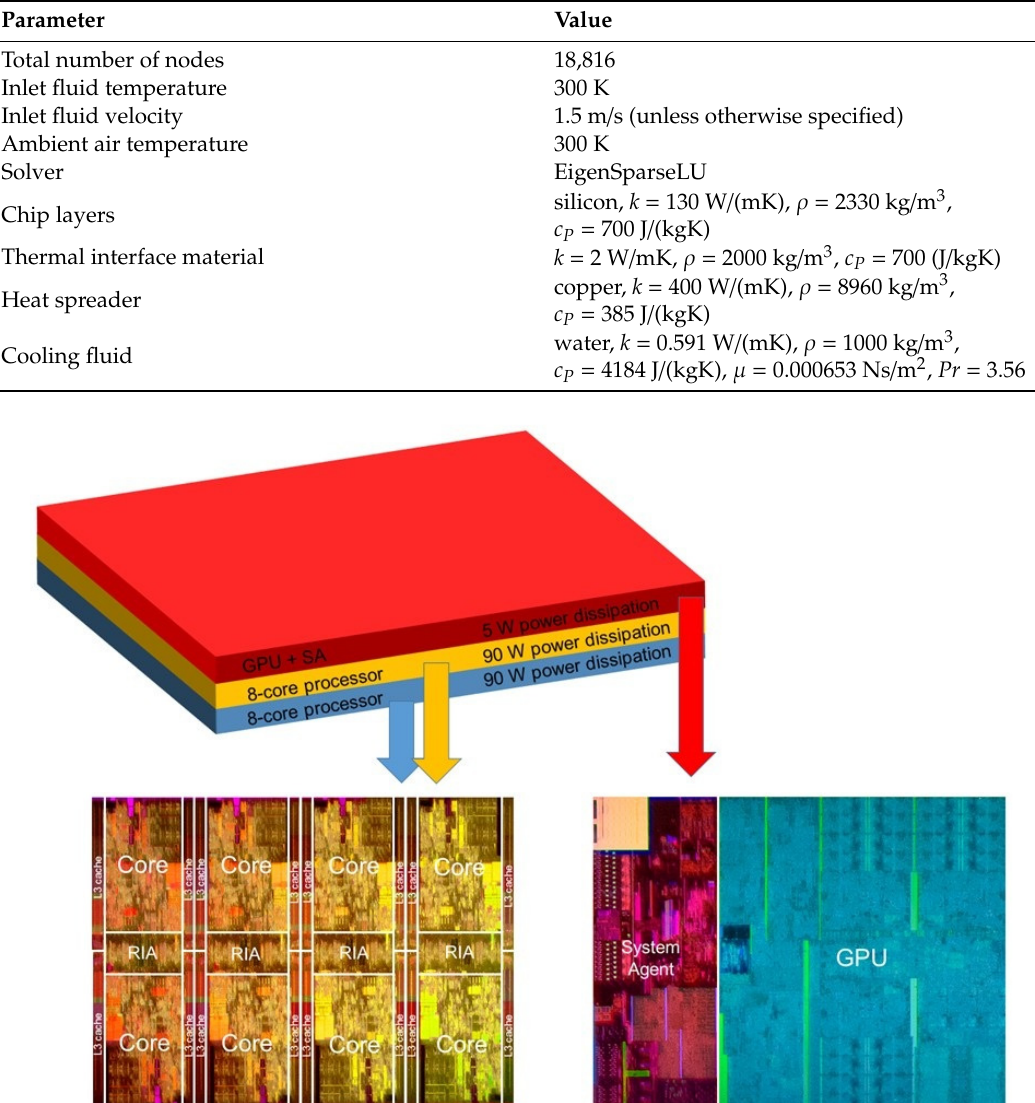
Figure 5. The 3D processor layers included in the 3D chip simulation model. ILD – inter-layer dielectric, TSV – through-silicon via. Table 1. 3D processor design parameters. Parameter Value Die area